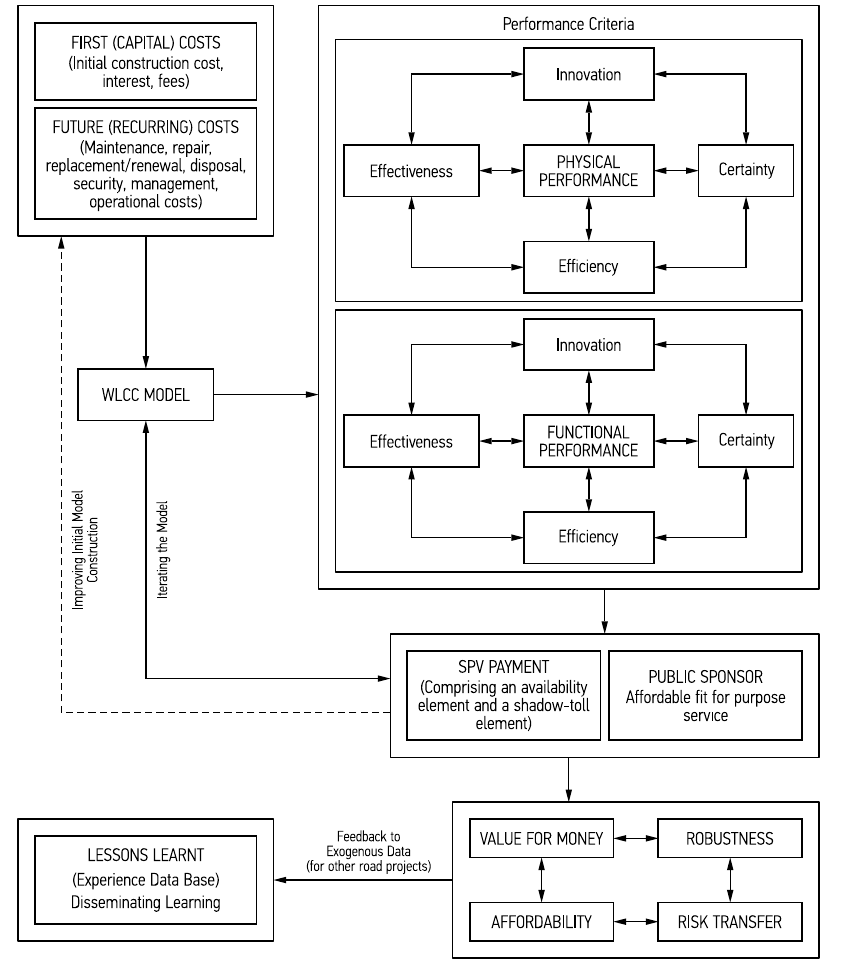
Fig. 3 . WLCC Framework for A92 PFI Road